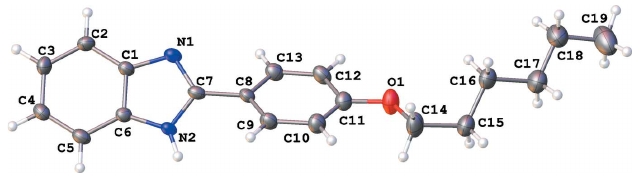
Figure 1 The molecular structure of 2-(4-hexyloxyphenyl)-1 H -benzimidazole ( 1 ), with displacement ellipsoids drawn at the 50% probability level.